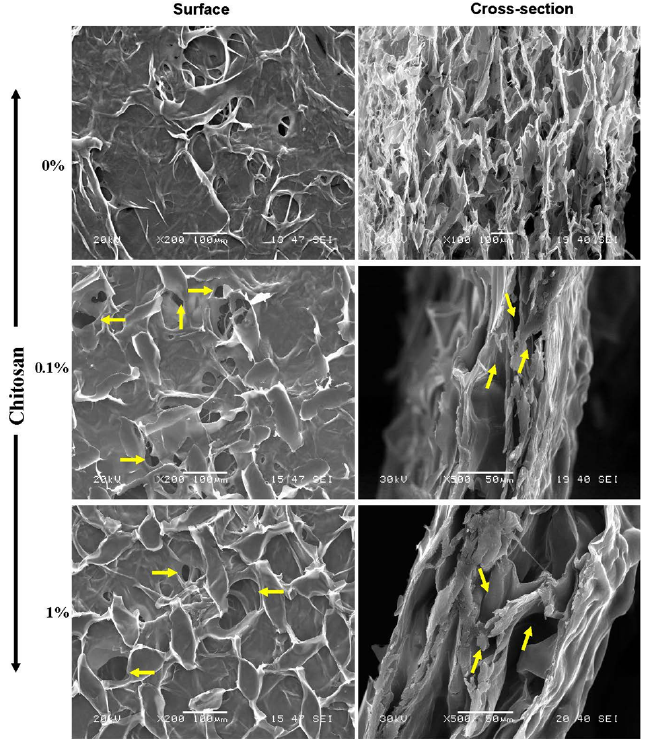
Figure 2. Scanning electron microscopy (SEM) analyses of chitosan-coated collagen membranes. Following material synthesis, chitosan-coated and non-coated membranes crosslinked with glutaraldehyde vapor were processed and analyzed under SEM. Structural analyses were performed on the surface of the membrane, and on the cross-sections ( n = 4).